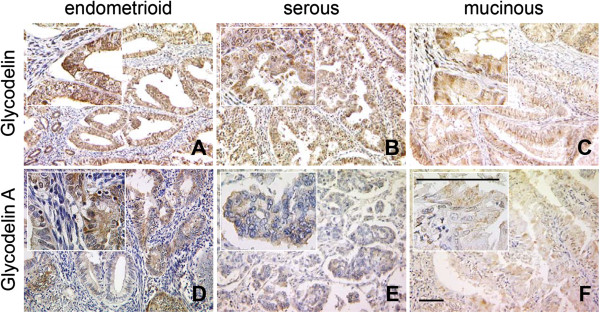
Glycodelin and Glycodelin A protein was detected in endometrial cancer tissue by immunohistochemistry. Representative microphotographs of Glycodelin (Gd, A-C) and its immunosuppressice glyco-variant Glycodelin A (GdA, D-F) as detected by immunohistochemistry in different histological subtypes of endometrial cancer tissue are shown. Pan-Glycodelin as well as its immunosuppressive glyco-variant Glycodelin A was found to be predominantly produced by epithelial components of endometrial carcinomas. Scale bars in F represent 100 μm and refer to A-F.